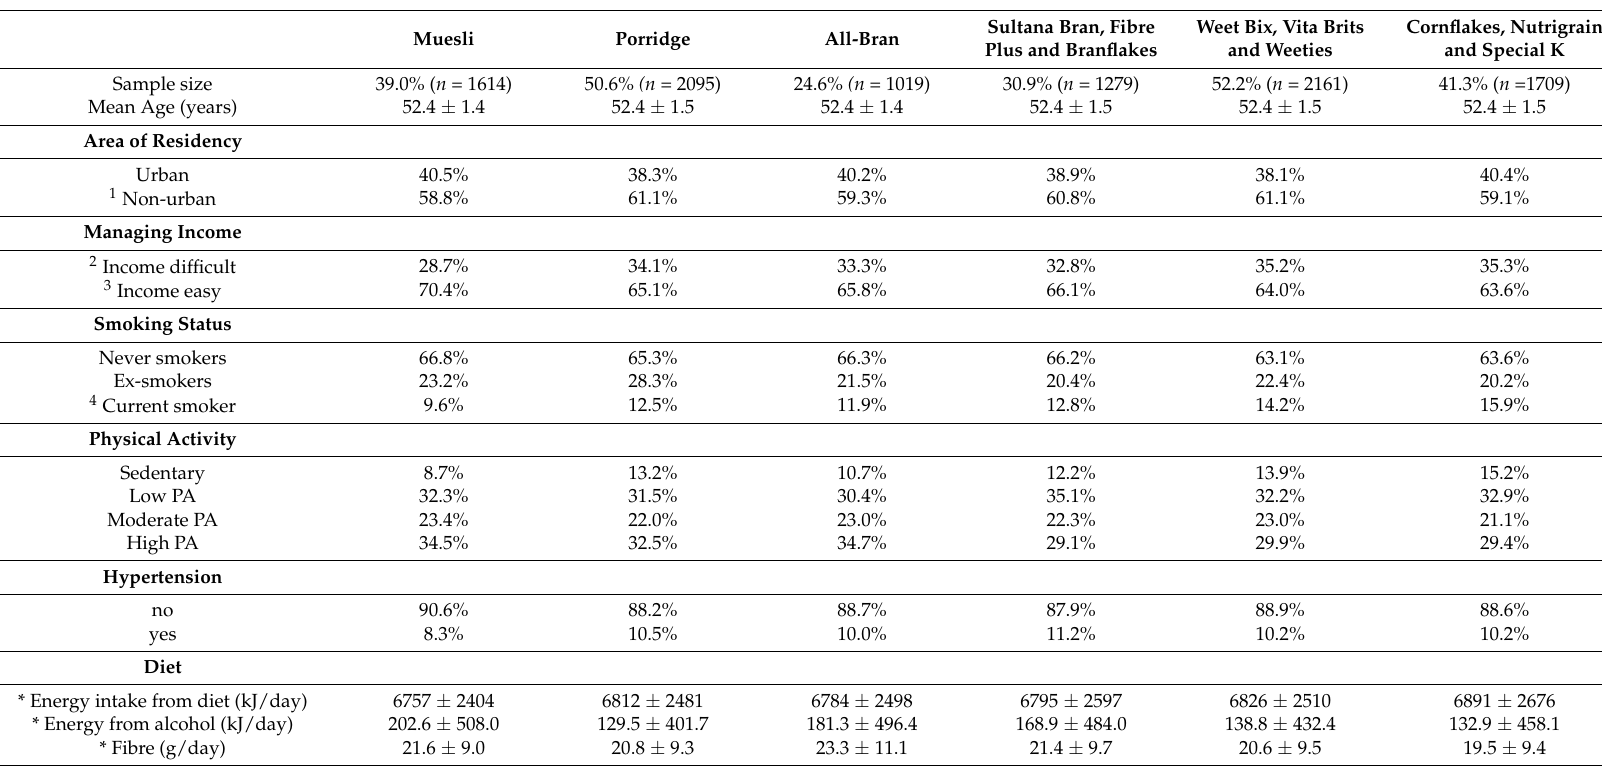
Table 2. Characteristics of participants from the mid-age (2001) cohort of the Australian Longitudinal Study on Women’s Health at Survey 3 ( n = 4143) by individual breakfast cereal